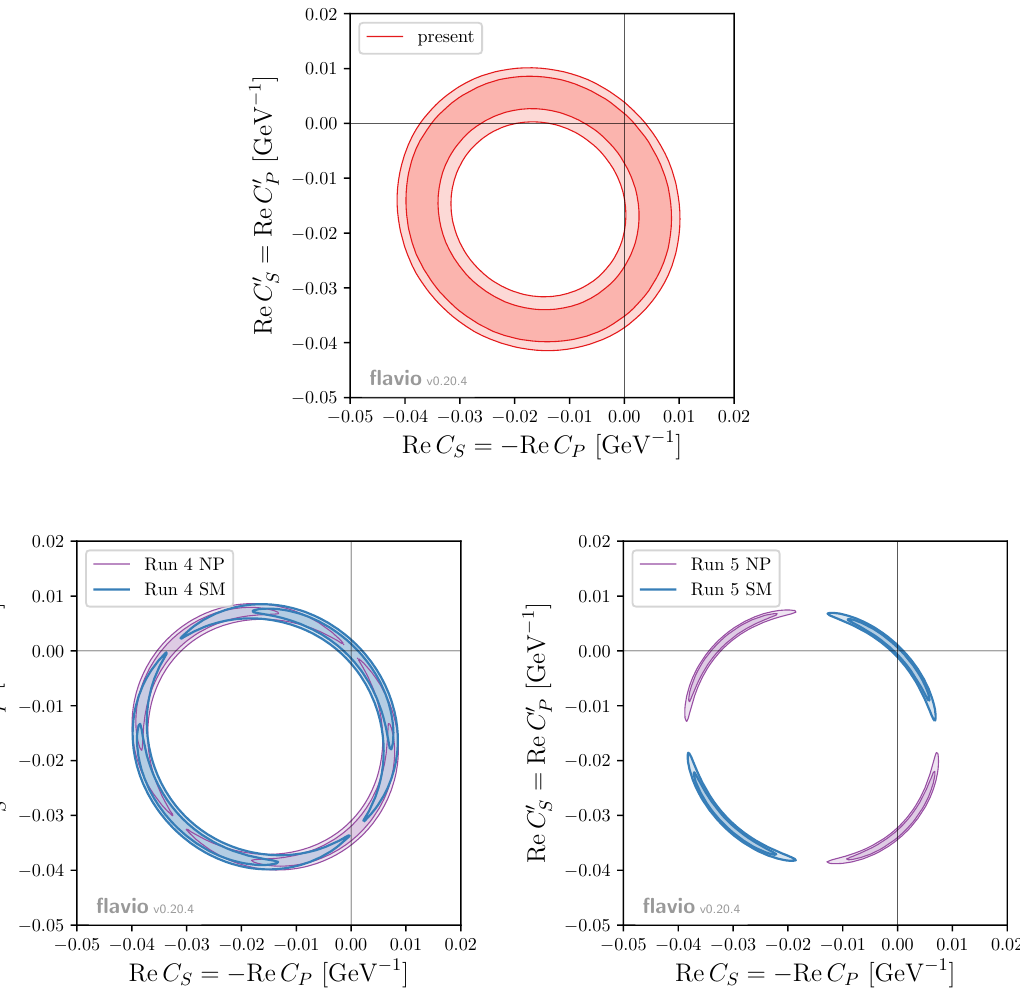
Figure 3 . Present (top) and future (bottom) constraints on the real parts of the Wilson coe(cid:14)cients C S and C 0 , assumed to satisfy the SMEFT relation (4.6), showing the 1 and 2 (cid:27) ( S and 6 : 18) contours. The NP scenario is the same as in (cid:12)gure